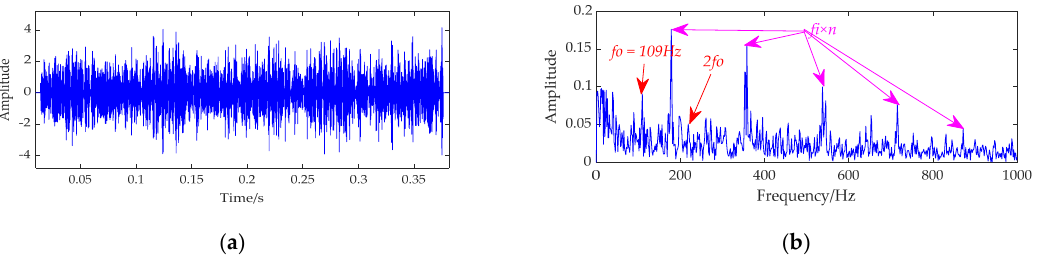
Figure 18. Envelope spectrum of mode 1.